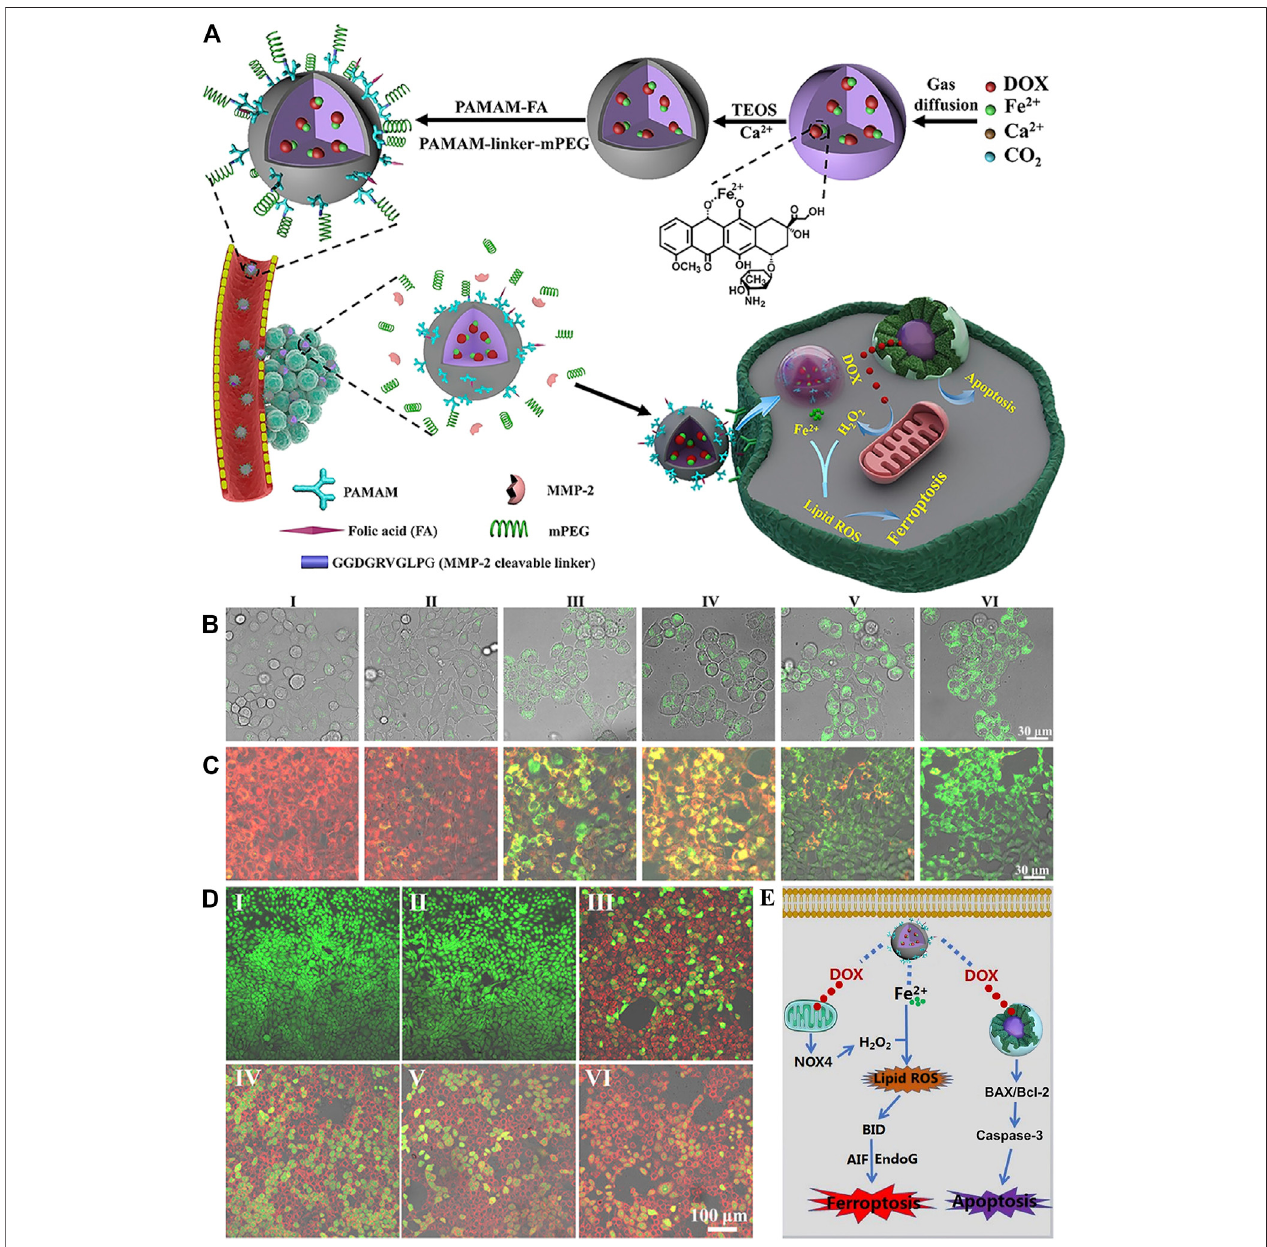
FIGURE 4 | (A) Synthesis scheme of ACC@DOX-Fe 2+ -Ca-FA/mPEG and its therapeutic action. (B – D) Confocal laser scanning microscopy observation in 4T1 tumor cells about the intracellular distribution of the LPOs (B) , the changes in the mitochondrial membrane potential (C) and apoptosis levels (D) after treatment with (I) PBS, (II) ACC-Ca-FA/mPEG, (III) DOX, (IV) ACC@DOX-Ca-FA/mPEG, (V) ACC@DOX-Fe 2+ -Ca-FA/mPEG, and (VI) MMP-2 – treated ACC@DOX-Fe 2+ -Ca-FA/mPEG. (E) Molecular mechanism for ACC@DOX-Fe 2+ -Ca-FA/mPEG-induced ferroptosis/apoptosis. Reproduced with permission from Xue et al., (2020) Copyright @ 2020